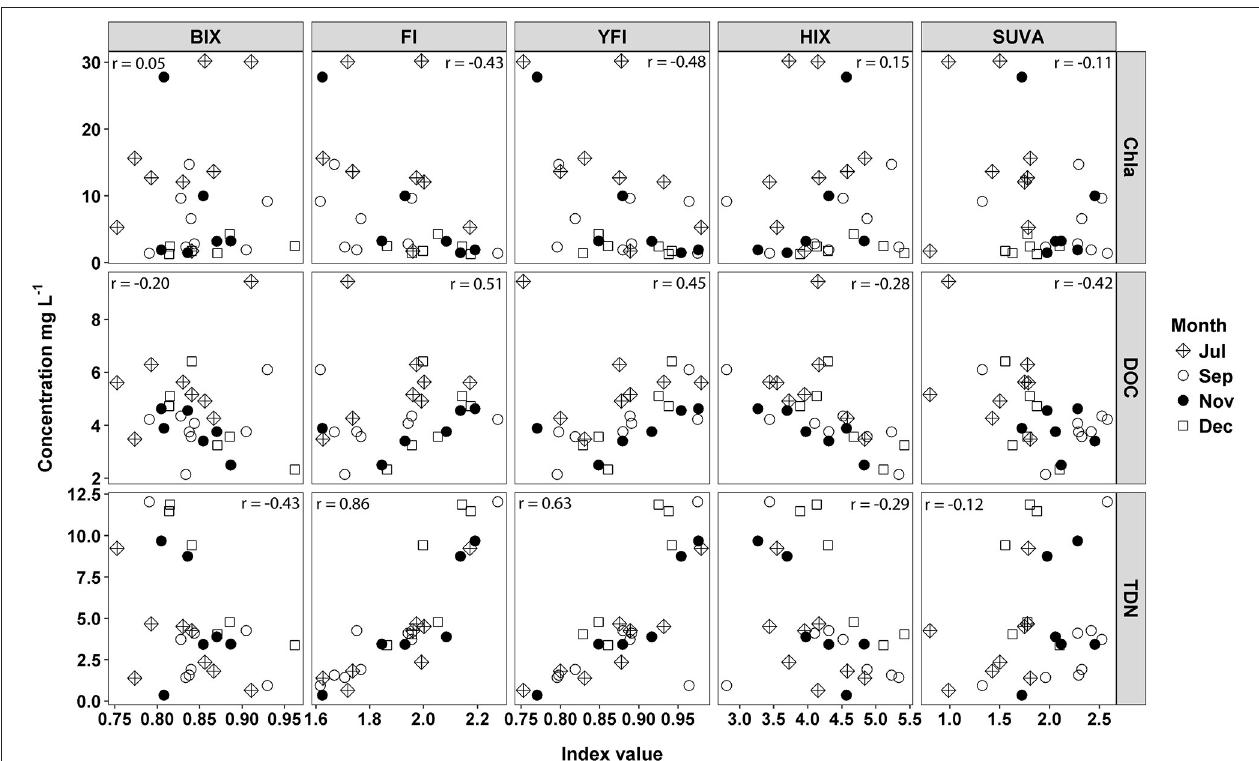
FIGURE 8 | Water quality metrics, chlorphyll a (Chla), dissolved organic carbon (DOC), and total dissolved nitrogen (TDN), regressed against five fluorescence indices, freshness index (BIX), flourescence index (FI), Yoeman index (YFI), humification index (HIX), and SUVA 254 . Pearson correlations were run between indices and water quality metrics for all months